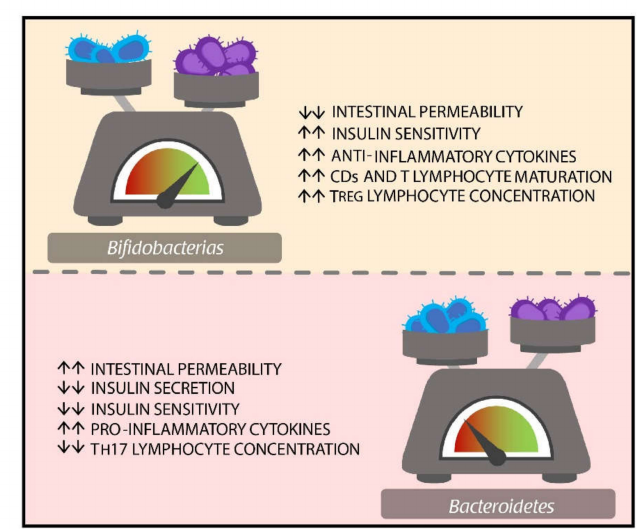
Figure 2. Main microorganisms seen in patients with DM2 and their potential role. DM represents a model of the wide heterogeneity of microbiome in humans and the poor role played by the Firmicutes / Bacteroidetes ratio as a gut microbiome homeostasis marker in certain diseases. In this particular case, the Bifidobacterium and Bacteroidetes genres are the main groups of microorganisms present in DM2 patients. Although they have potential antagonist functions, these have not been completely elucidated. Abbreviations: DM: Diabetes mellitus; Treg: Regulatory T Cells; CDs: Dendritic Cells; Th17: T Helper 17